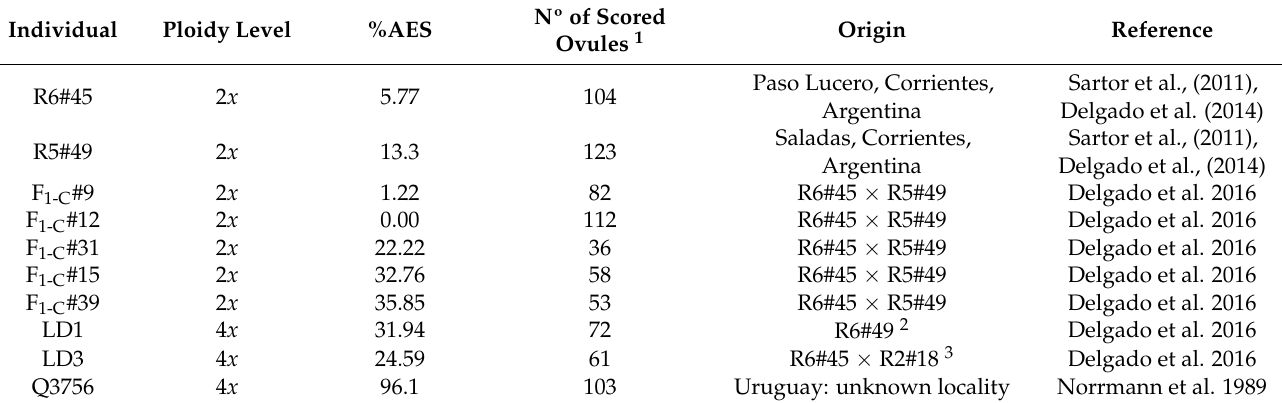
Table 1. Description of the genotypes used in the present work that had been previously characterized in Corrientes. Individual Ploidy Level %AES